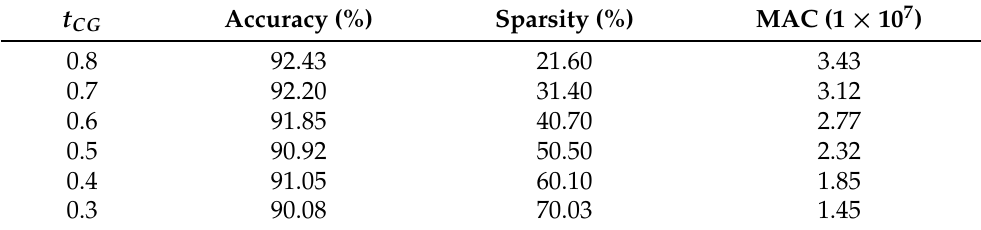
Table 6. Effectiveness of CSGN (CG) according to target rate with baseline ResNet20.